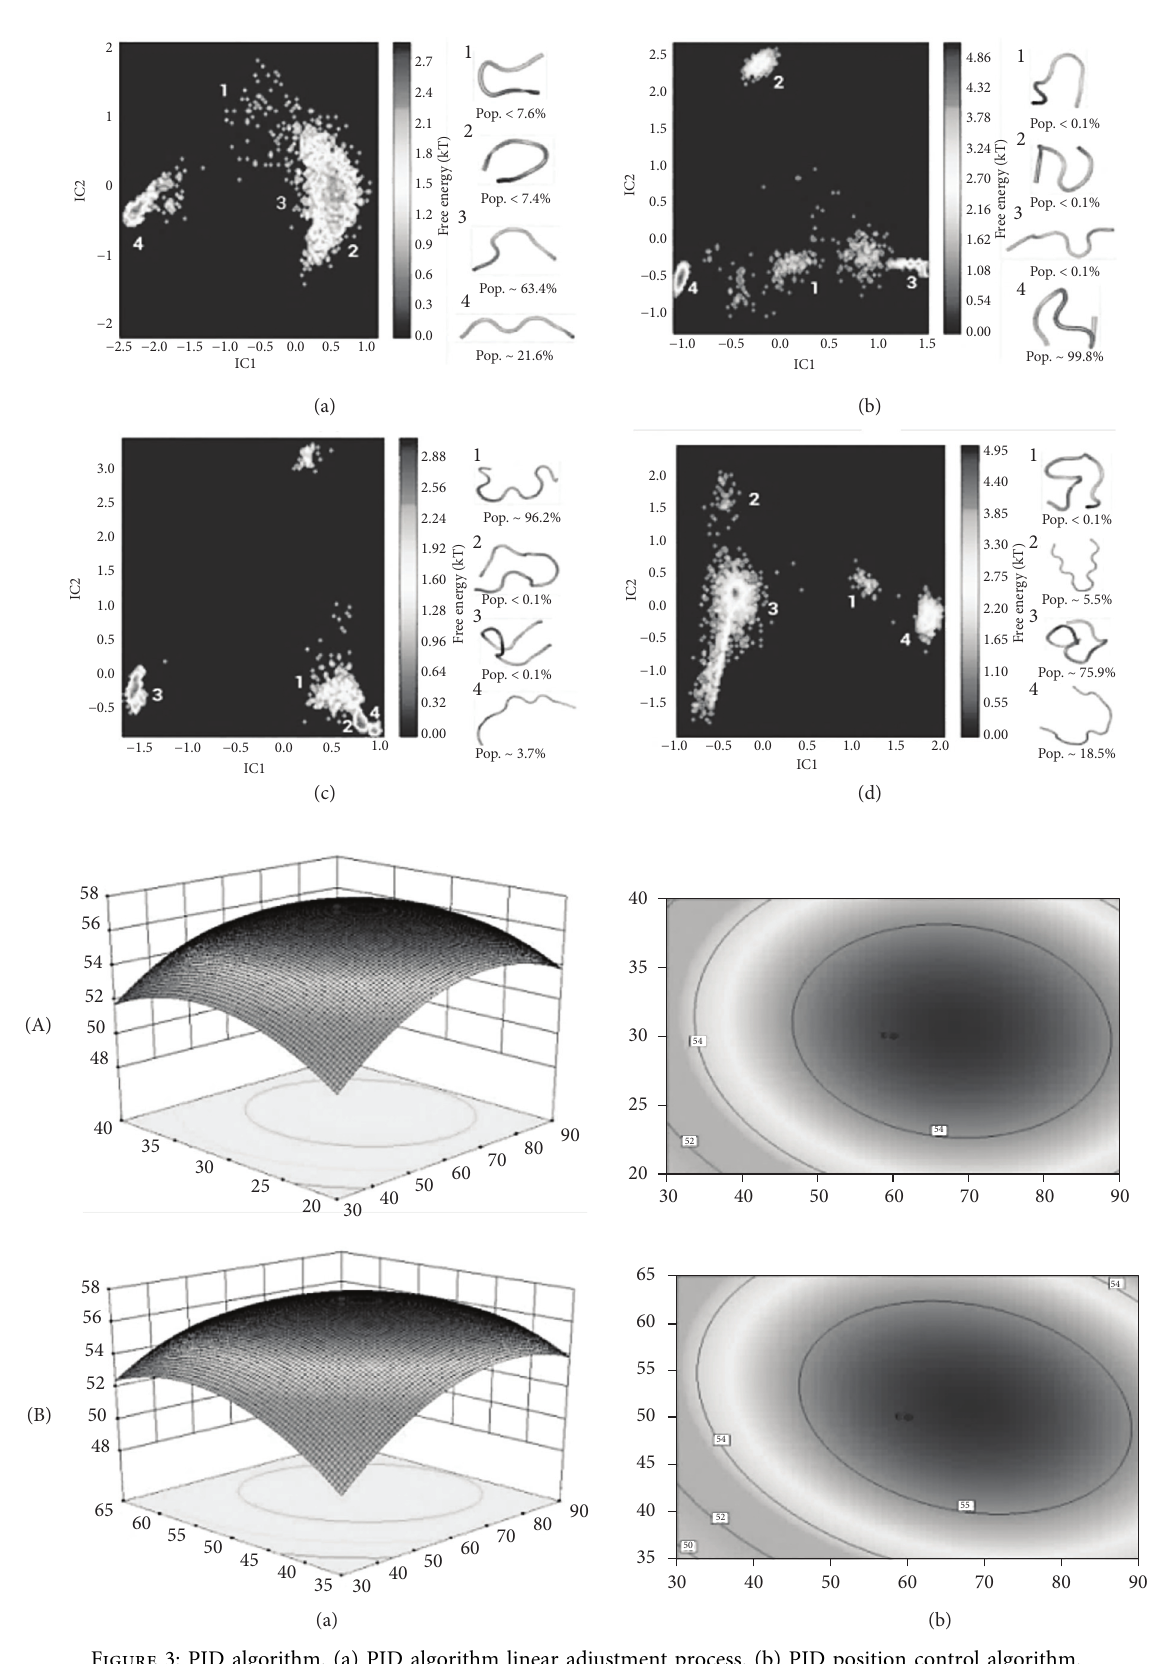
Figure 3: PID algorithm. (a) PID algorithm linear adjustment process. (b) PID position control